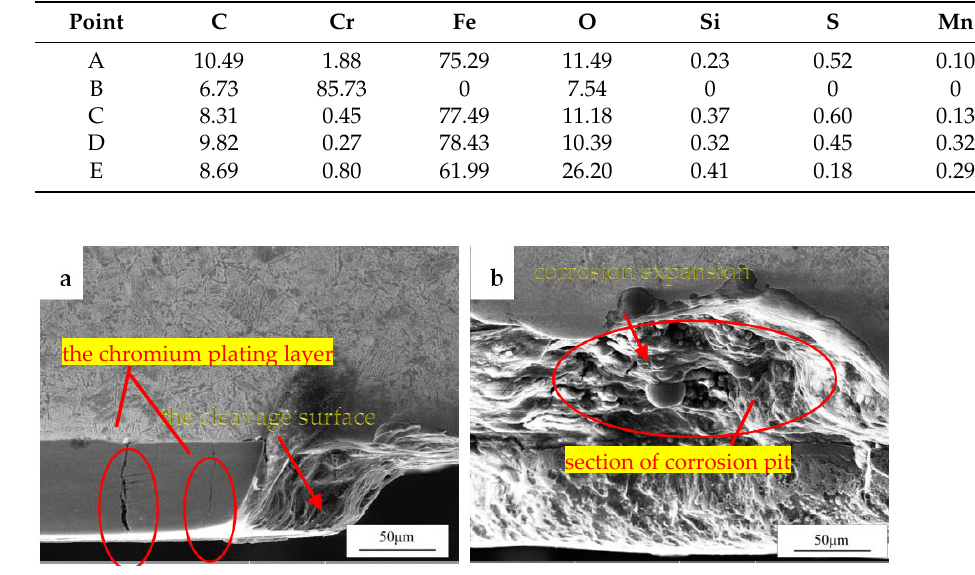
Figure 6. SEM morphology observation: ( a ) a fractured chromium layer; ( b ) section of corrosion pit .